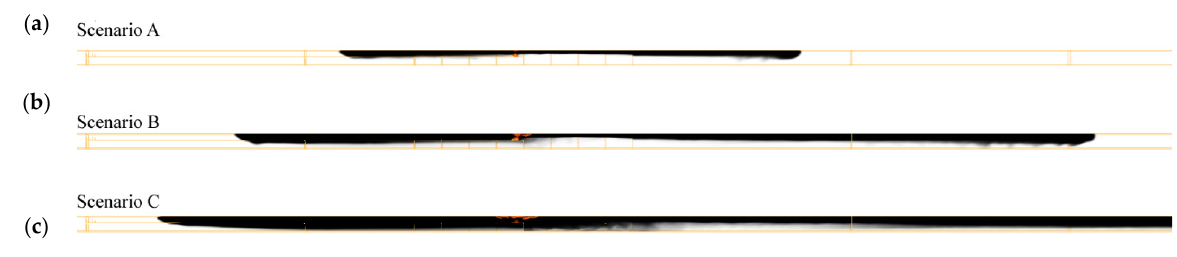
Figure 9. Smoke dispersion along the tunnel and backlayering at the jet fan activation time frame for ( a ) Scenario A at +180 s, ( b ) Scenario B at +300 s, and ( c ) Scenario C at +480 s. As shown in Figure 10, the temperatures at the ceiling above the fire source are in good agreement with the RABT ZTV fire curve in the first minutes of the simulation. Then, when the ventilation system was activated, the temperature dropped and reached a steady value of around 450 °C.